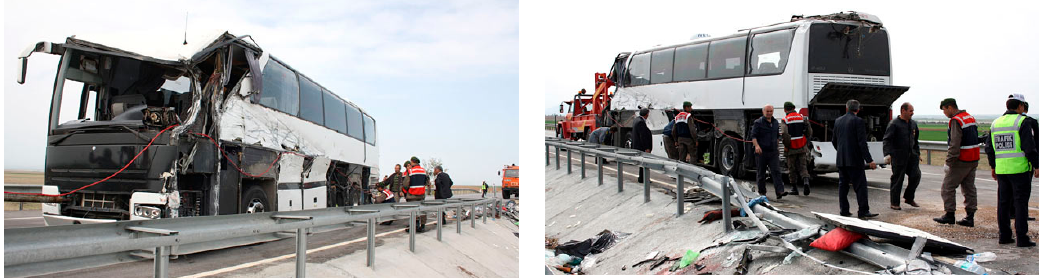
Figure 2. A bus accident at a V-shaped ditch protected with steel longitudinal barrier.